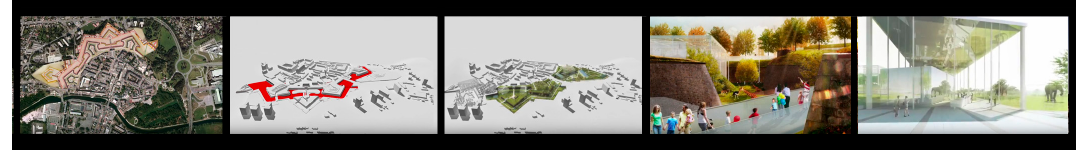
Figure 10. MVRDV, Zooban, Maubeuge, France. Movie by Luxigon (6:05), 2013